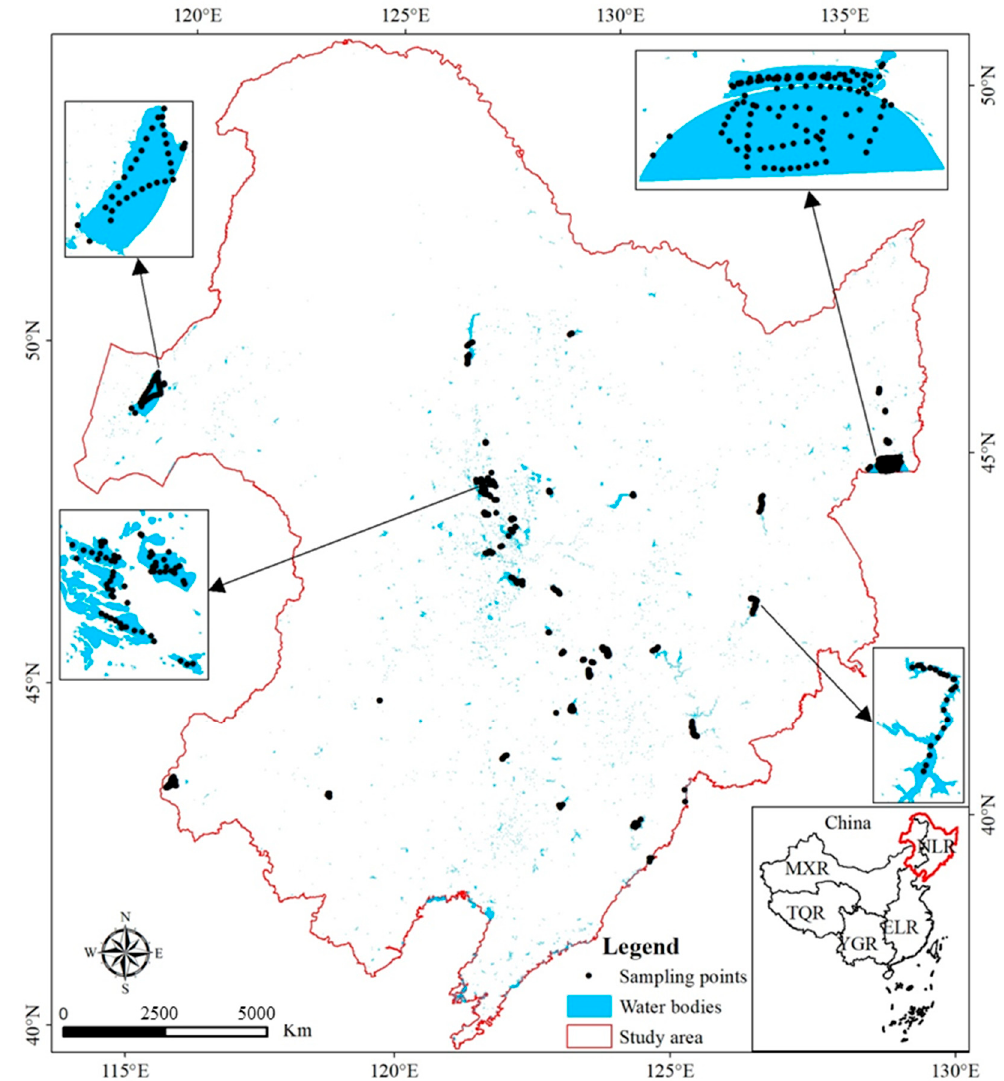
Figure 1. The study area and distribution of the sampling points.